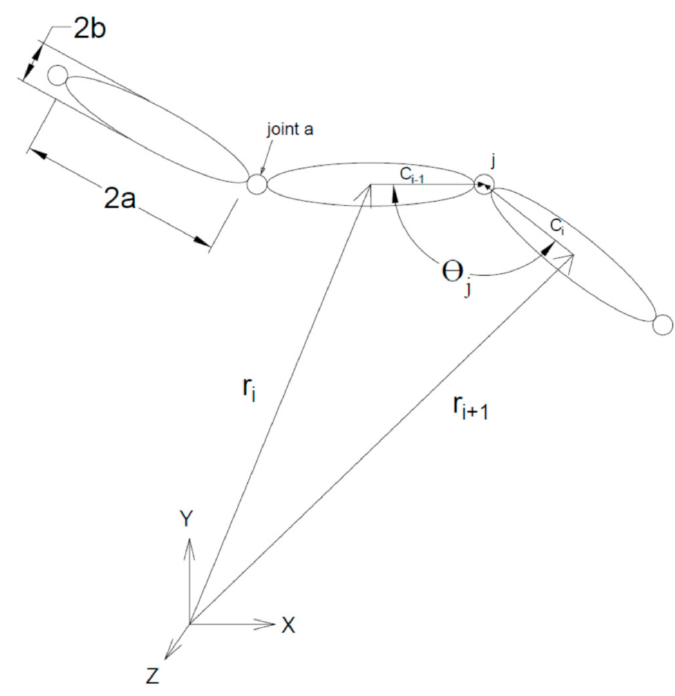
Figure 4. Illustration of multiple spheroids as a model of a single